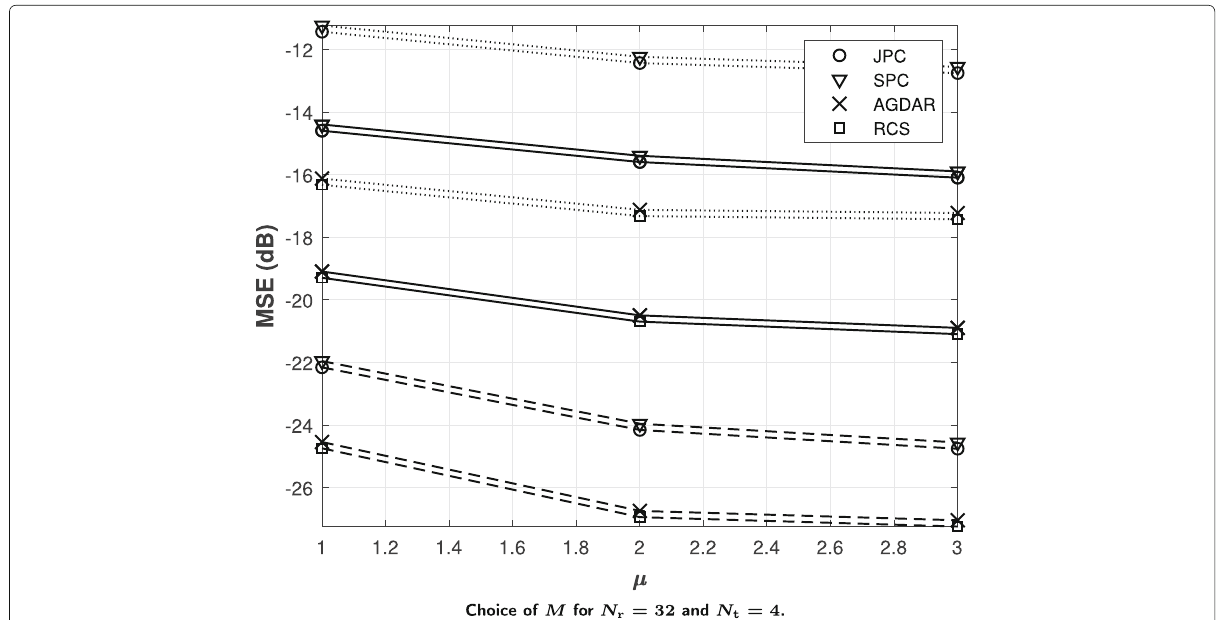
Fig. 8 Choice of M for N r = 32 and N t = 4. MSE vs μ for ULA with N r = 128 and N t = 16 at an SNR of 0 (dotted lines), 10 (solid lines), and 20 dB (dashed lines) and M 1 = μ N r and M 2 = μ N t . UMi LOS